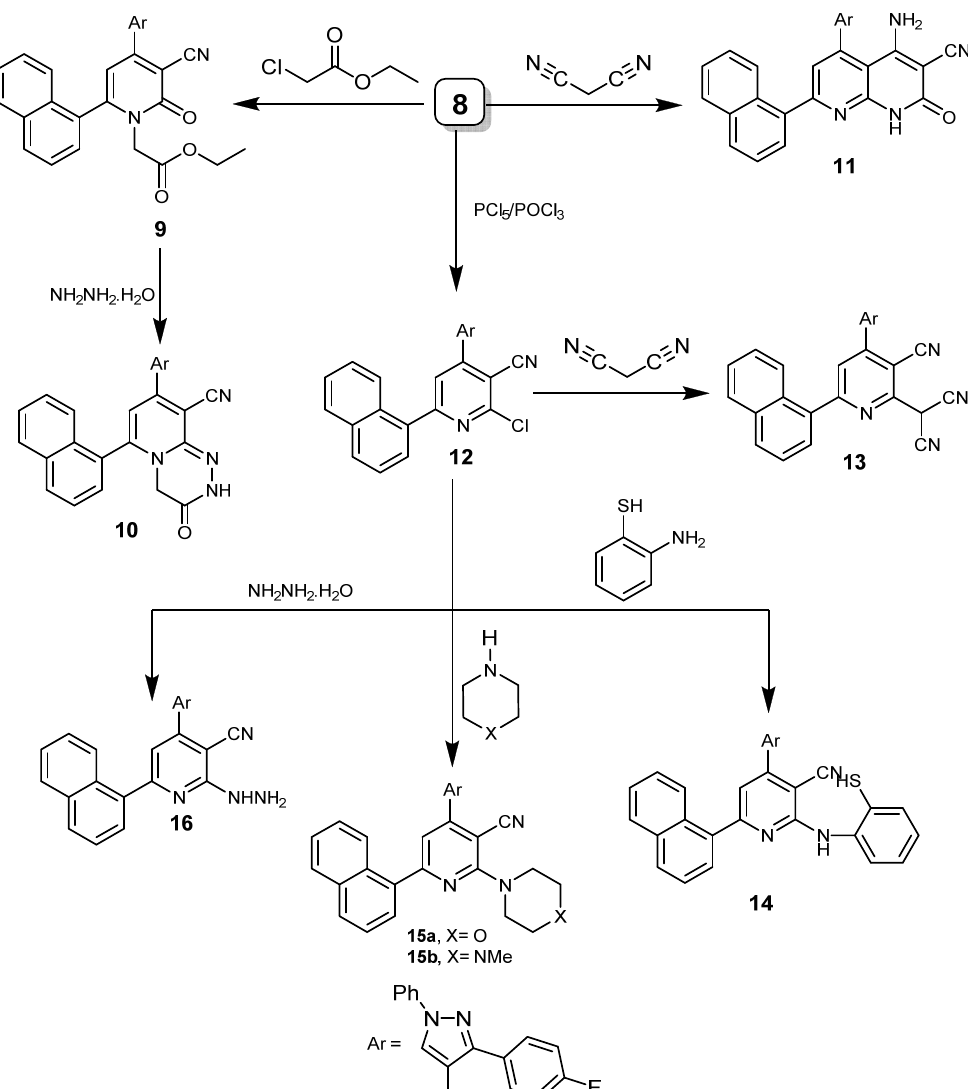
Scheme 2. Synthetic route for compounds 9 – 16.